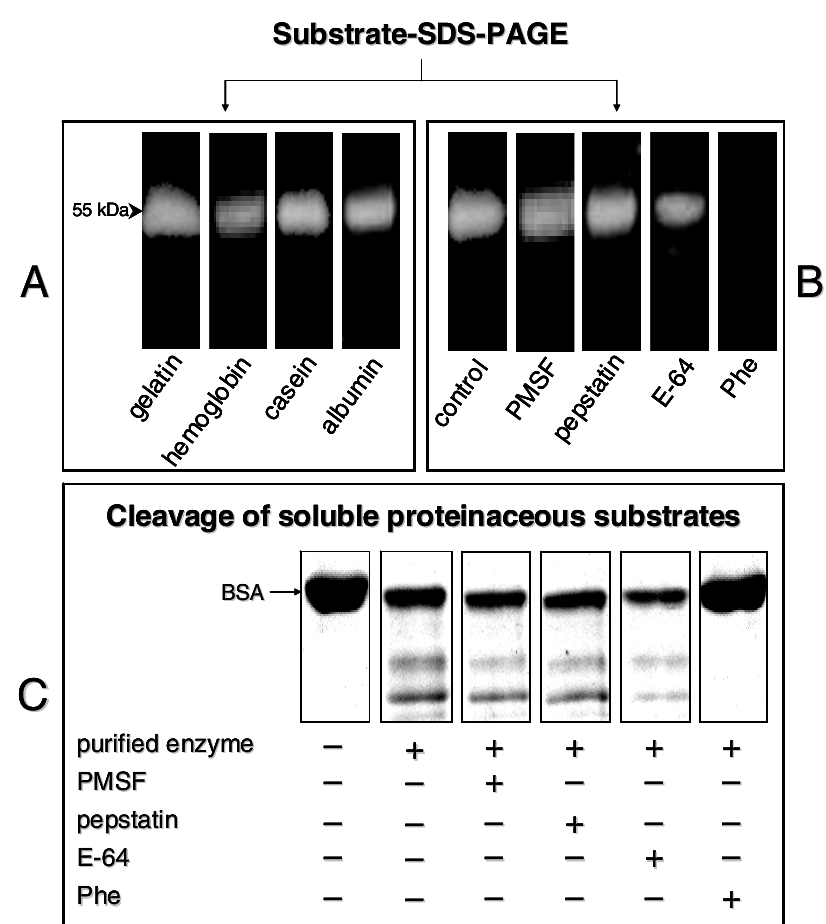
Fig. 5 – Susceptibiliy of different protein substrates to cleavage by the 55 kDa cell-associated purified protease from Blastocrithidia culicis ( A ). Modulation of the 55 kDa protease activity in the absence ( control ) or in the presence of different proteolytic inhibitors: 10 mM phenylmethylsulfonyl fluoride ( PMSF ), 1 µ M pepstatin , 10 µ M trans -epoxysuccinyl L -leucylamido-(4-guanidino) butane ( E-64 ) and 10 mM 1,10-phenanthroline ( Phe ) ( B ). The gel strips were incubated in phosphate buffer (pH 6.0) for 20 h at 37 ◦ C. The experiments were executed as described elsewhere (d’Avila-Levy et al. 2003, 2005a, Elias et al. 2006). Alternatively, the purified 55 kDa metalloprotease was mixed with a proteinaceous soluble substrate (in this case, bovine serum albumin - BSA) and incubated at 37 ◦ C for 5 h in the absence or in the presence of the above proteolytic inhibitors. In the control lane, BSA was incubated only with PBS. The reaction mixtures were terminated by freezing, and the protein degradation profile was analyzed on SDS-PAGE. For experimental details see Silva et al.